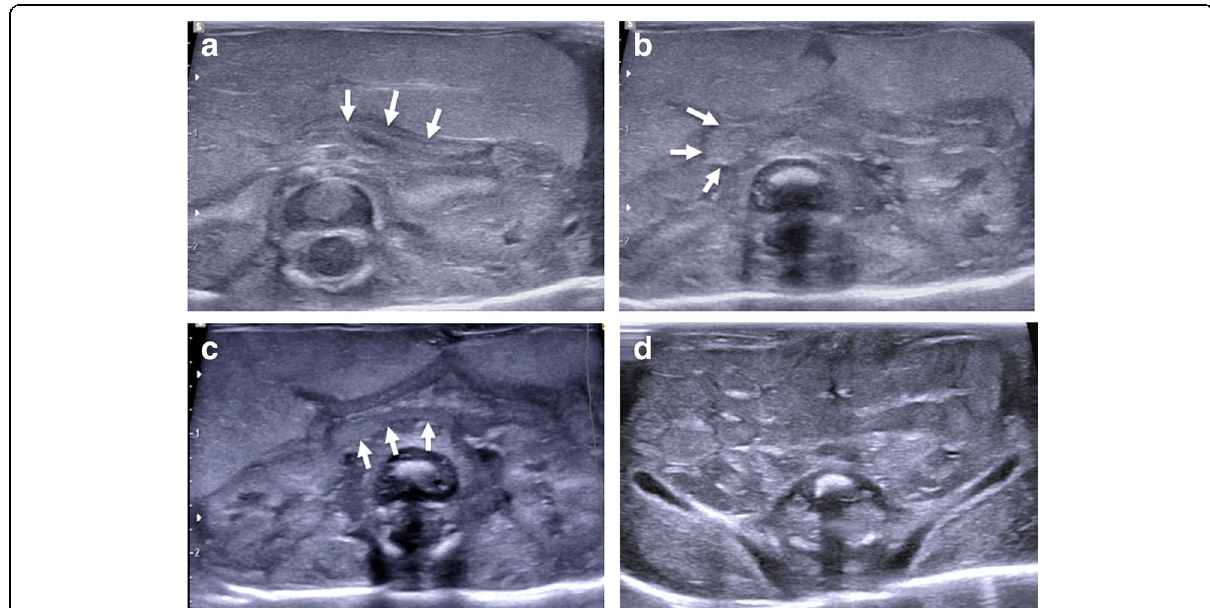
Fig. 18 Normal transverse postmortem ultrasound appearances of the bowel in a 19-week gestational-aged foetus, obtained 8 days after death. The first three images ( a – c ) demonstrate normal rotation of the bowel. In image ( a ), the gastric pylorus becomes the first part of the duodenum (solid white arrows) and is seen to cross the midline to the right of the abdomen. In image ( b ), the second part of the duodenum is shown (white arrows), and finally, in image ( c ), this becomes the third part of the duodenum as it crosses back to the left side of the abdomen (white arrows). In image ( d ), normal small and large bowel loops in the lower abdomen are seen and meconium filled, without any significant bowel